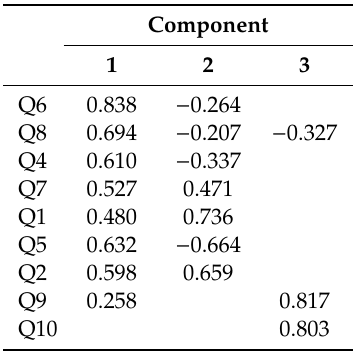
Table A6. Component Matrix a